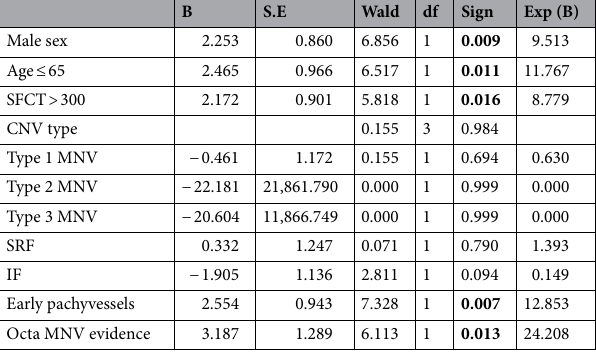
Table 3. Results of logistic regression analysis. Significant values are in bold.